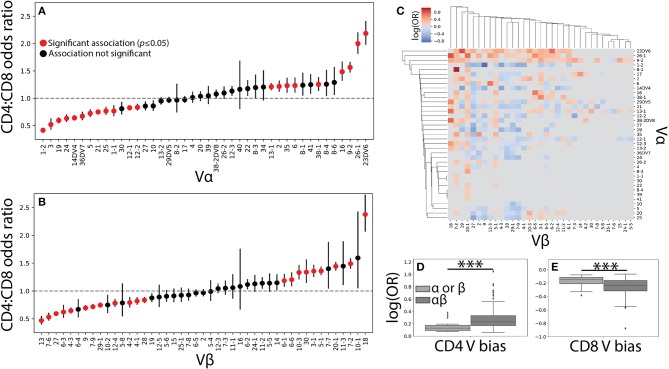
Vαβ pairings encode strong associations with T cell lineage. (A) The CD4+ and CD8+ TCR repertoires were then pooled across individuals and the CD4+:CD8+ odds ratio (OR) was calculated for each Vα and (B) Vβ germline region. An OR> 1 represents a CD4+ bias, while an OR< 1 represents a CD8+ bias with error bars representing the 95% confidence interval. The mean is represented by a red or black dot, with red representing statistical significance at p<0.05 by Fisher's exact test after Bonferroni correction. (C) Significant (q < 0.05 by Fisher's exact test) log odds ratios reveals strong CD4+:CD8+ biases for 349 Vαβ pairs. (D) Boxplots were calculated for the set of all significant odds ratios associated with single chains (Vα or Vβ) and compared with those associated with αβ pairs. Paired associations for both CD4+ and (E) CD8+ status were significantly stronger (***p < 0.001 by Mann-Whitney U test) than those for the single chain alone.